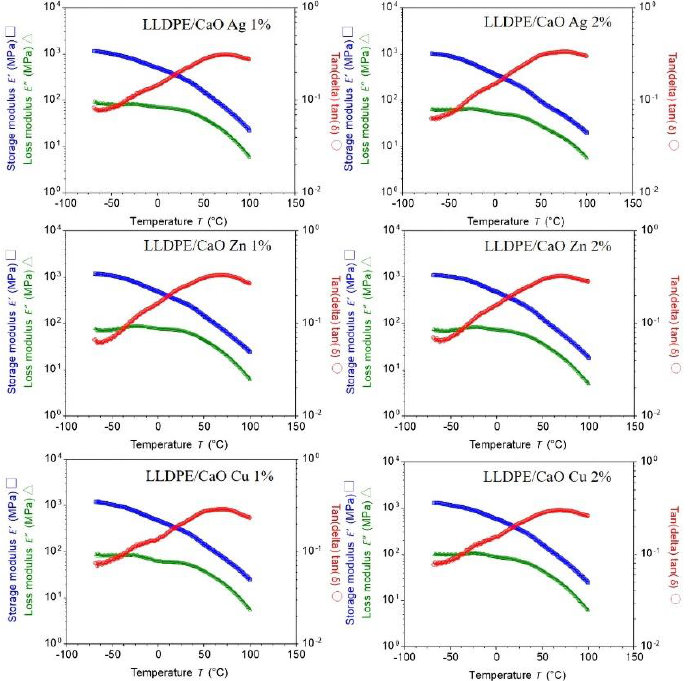
Figure 7. Typical DMA thermogram of PE/CaO with a different metal ion (Ag, Zn, Cu). Storage m odulus (E’) and loss m odulus (E’’), and loss factor tan (delta) are plotted as a function of temper- ature.